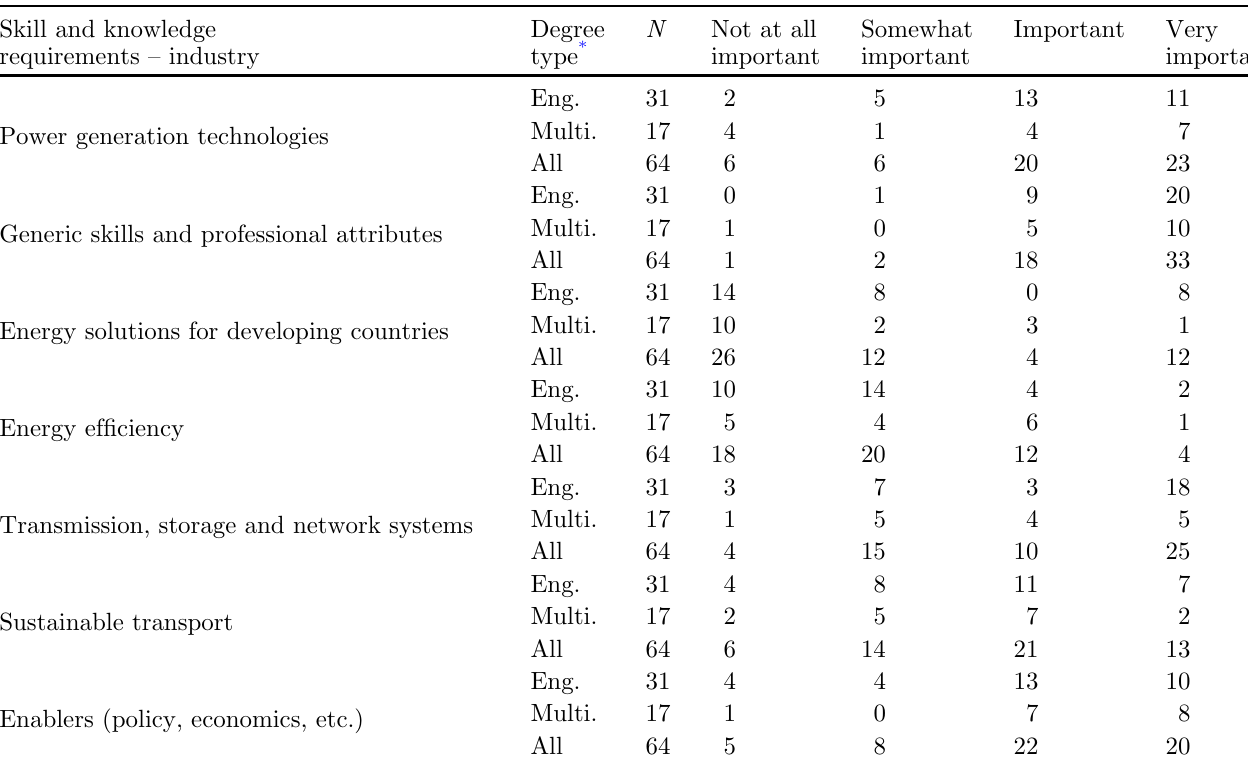
Table 1. Graduates ’ ratings of the importance of the main sustainable energy skills and knowledge areas. Skill and knowledge requirements –